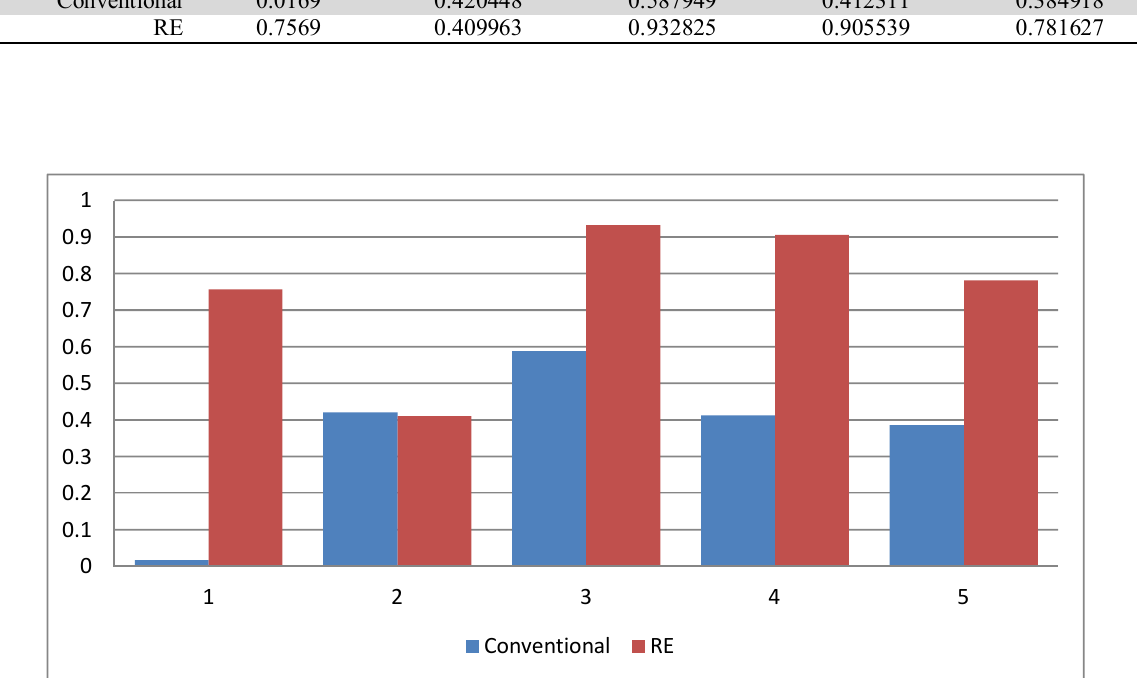
Fig 3. Selection of best alternative using max-min